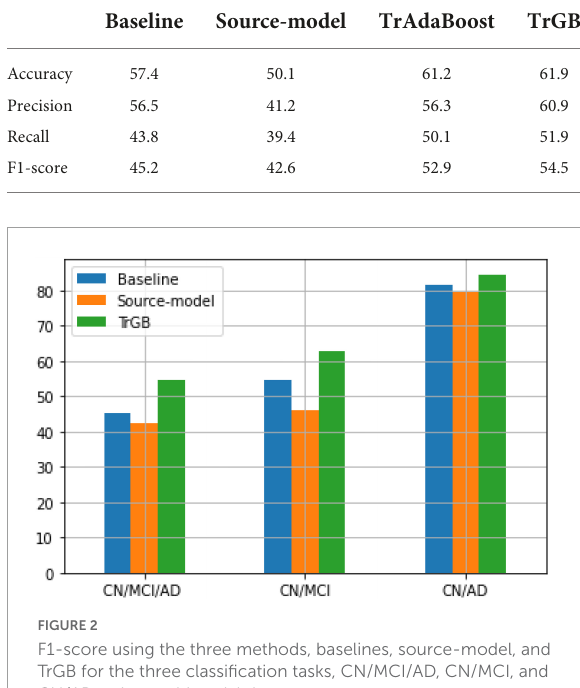
TABLE 7 CN/MCI/AD classification scores for the baselines, source-model, TrAdaBoost, and TrGB scenarios using the multimodal data.